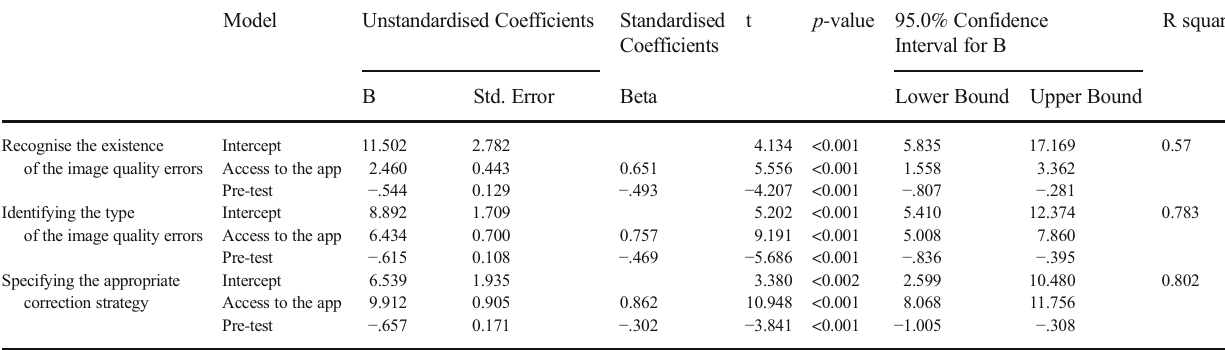
A table demonstrating a multiple linear regression used to evaluate the impact of the app on radiographers ’ knowledge Model